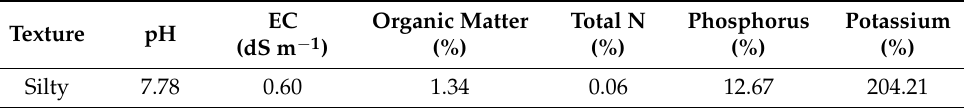
Table 1. Selected soil physical and chemical properties for the intercropping-biofertilizer study in